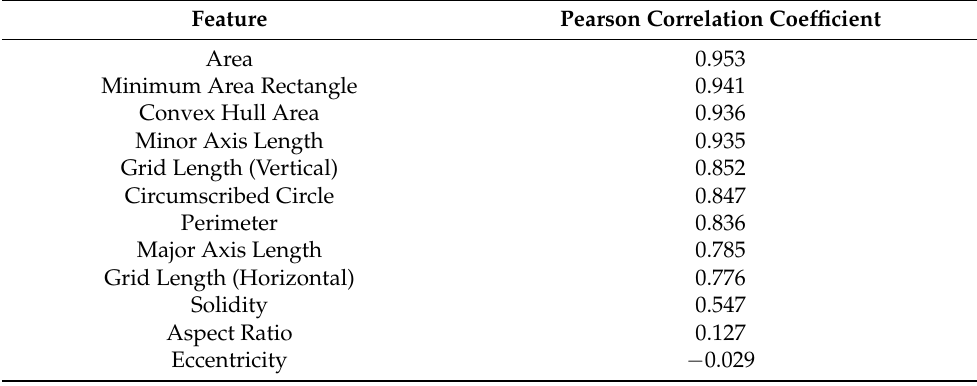
Figure 12. Features: ( a ) perimeter; ( b ) convex hull area; ( c ) minimum area rectangle; ( d ) circum- scribed circle. Table 2. Features selected for the FSS method and their correlation